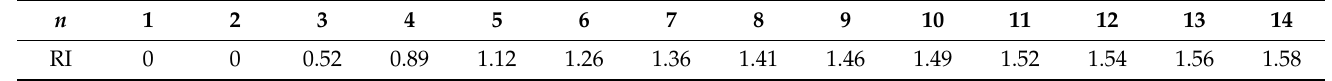
Table 3. Random consistency index ( RI )